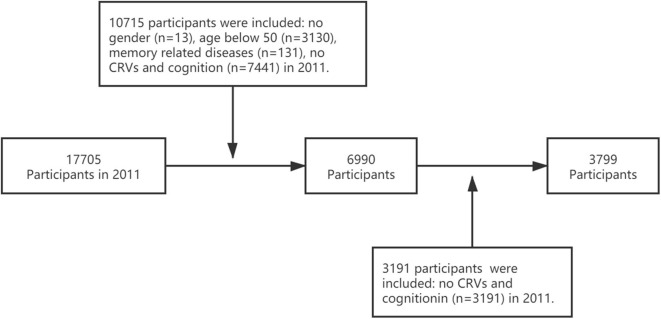
Flowchart of included participants.